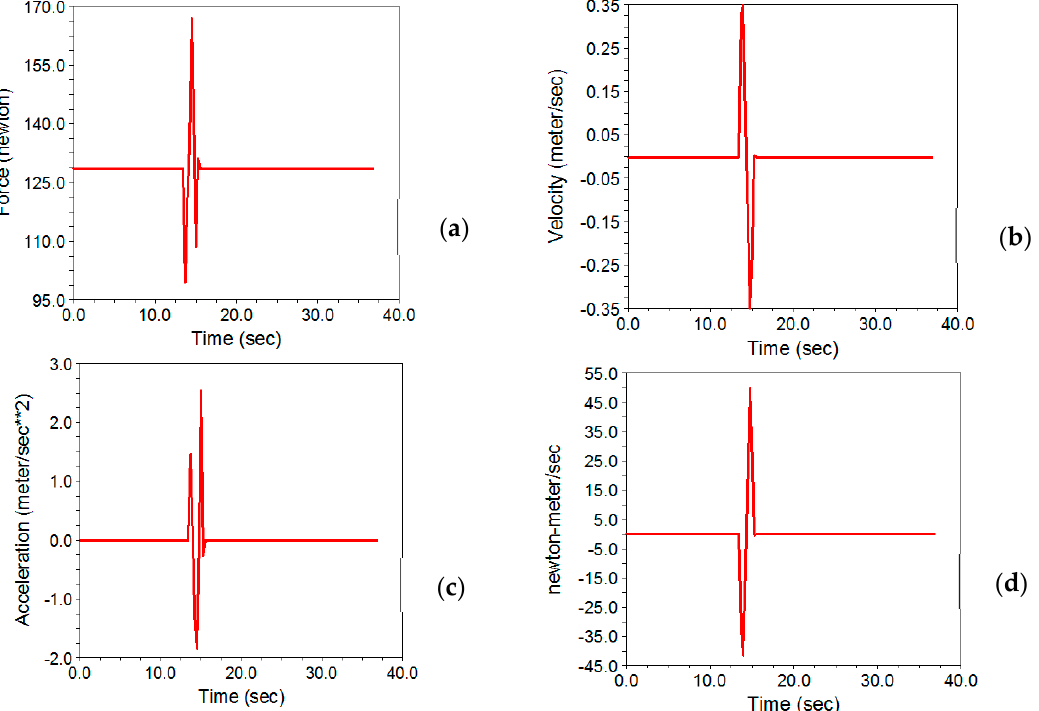
Figure 21. Results of ADAMS software simulation to determine the motor characteristics of the gutting subset (seven fish per minute). In this figure, ( a – d ) are force, velocity, acceleration, and required power respectively.